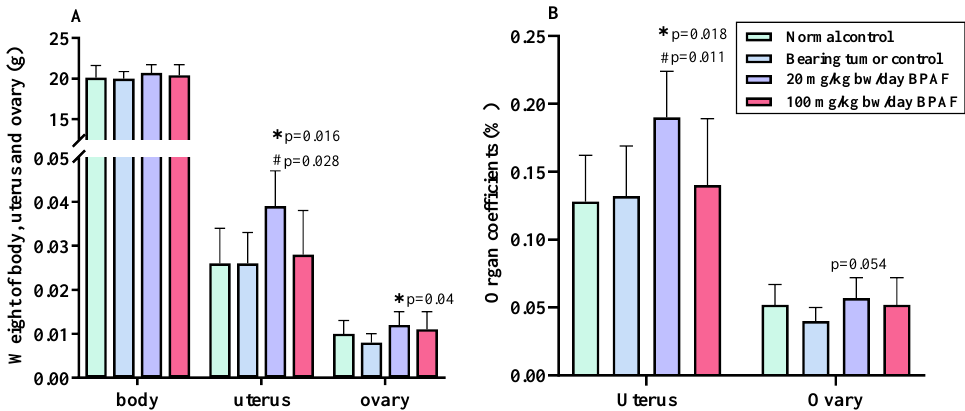
Figure 1. Effect of BPAF on the weight of body, uterus and ovary and organ coefficients of Balb/cA nude mice with SK-BR-3 xenograft tumor. ( A ): the wight of body, uterus and ovary; ( B ): Uterine and ovarian coefficients. The data represented the mean ± SD of six parallel mice samples. * p < 0.05, relative to SK-BR-3 bearing tumor control; # p < 0.05, relative to normal control.